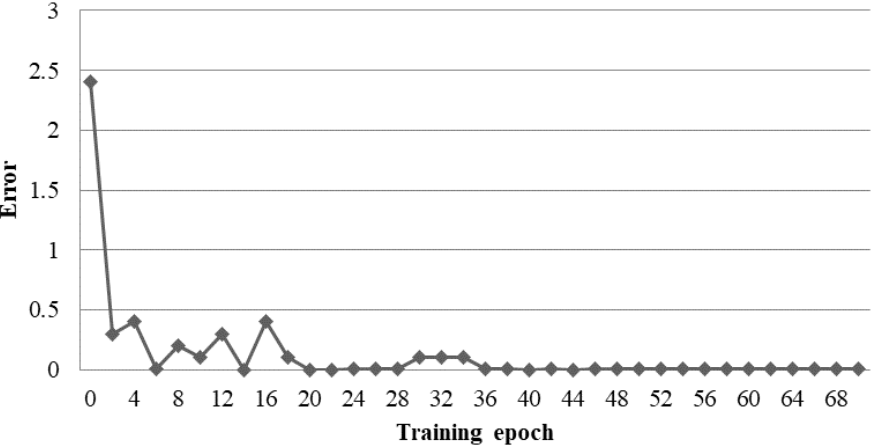
Figure 13. Percentage error in training process of RNN converges.